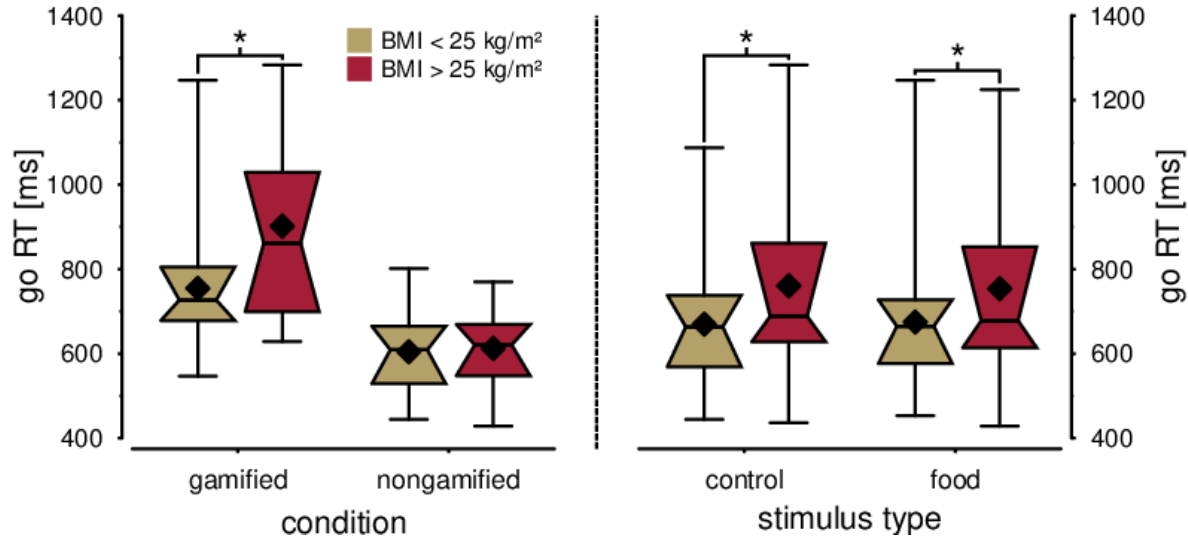
Figure 4. Effects of gamified versus nongamified stop-signal task and control versus food stimulus type on mean reaction times in go-trials. Longer reaction times of the overweight group were observed in the gamified stop-signal task but not in the nongamified stop-signal task. This effect was slightly larger for control stimuli; there was no significant stimulus difference within or across groups. RT: reaction time.